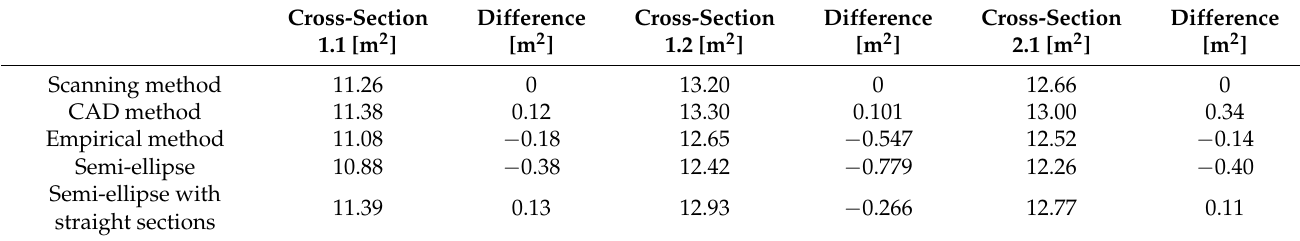
Table 2. Results of cross-sectional area measurements.